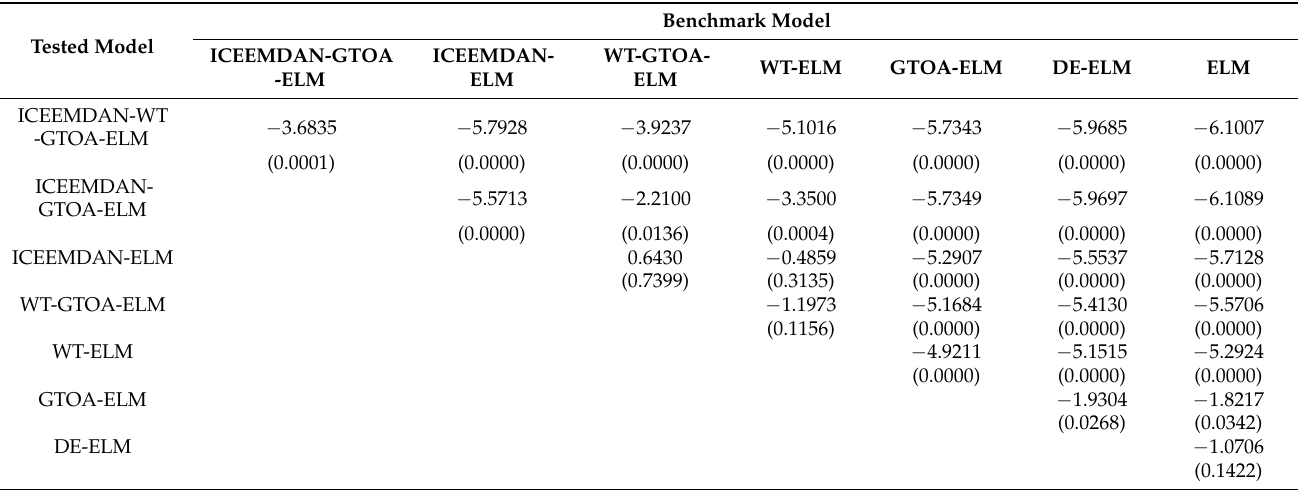
Table 2. DM test results of two-step ahead forecasting of PM10.